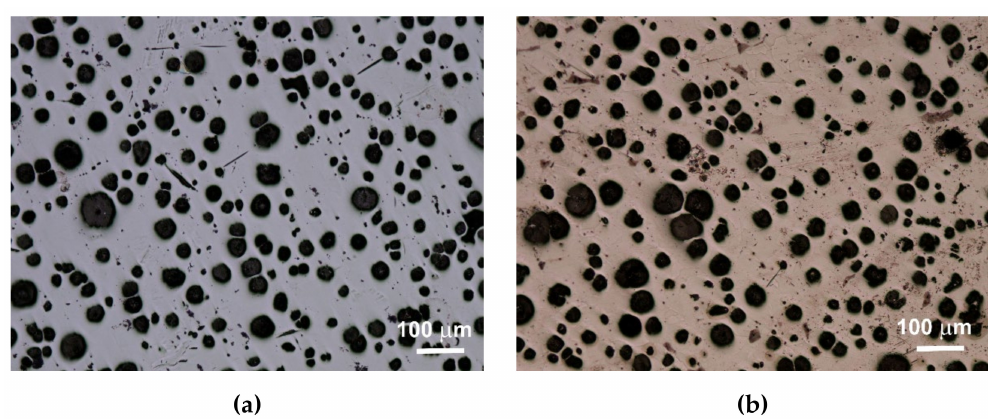
Figure 5. Microstructure of sample 9 non-etched ( a ) and etched ( b